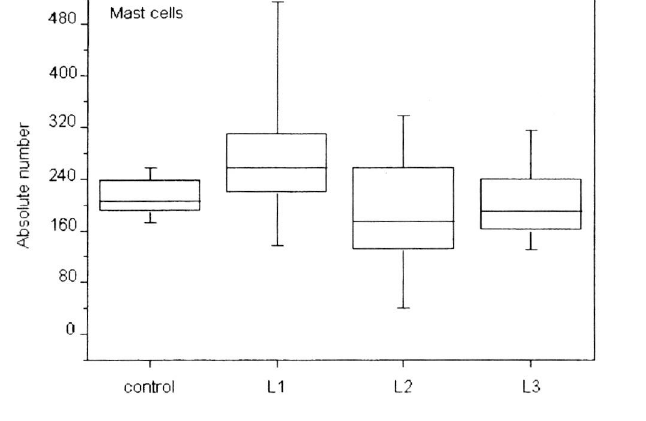
Fig. 7. - Box and whisker plots representing mast cells in the skin of control rats and those infested with Dermatobia hominis based on larval development (Kruskal-Wallis test).